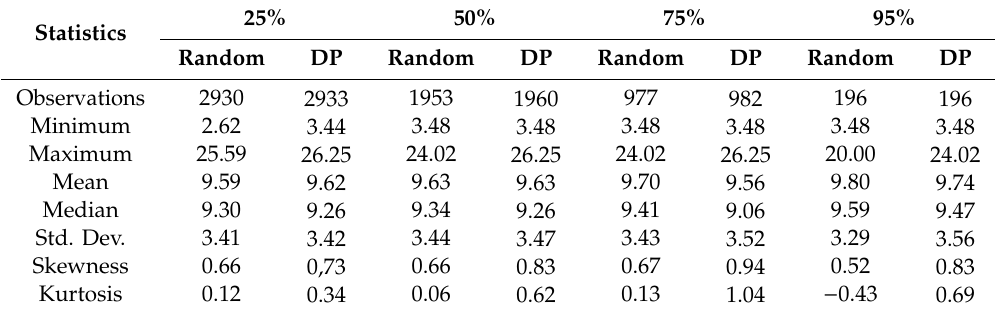
Table 5. Descriptive statistics results for soil ECa datasets from the di ff erent sample density reductions (i.e., 25%, 50%, 75%, and 95%).